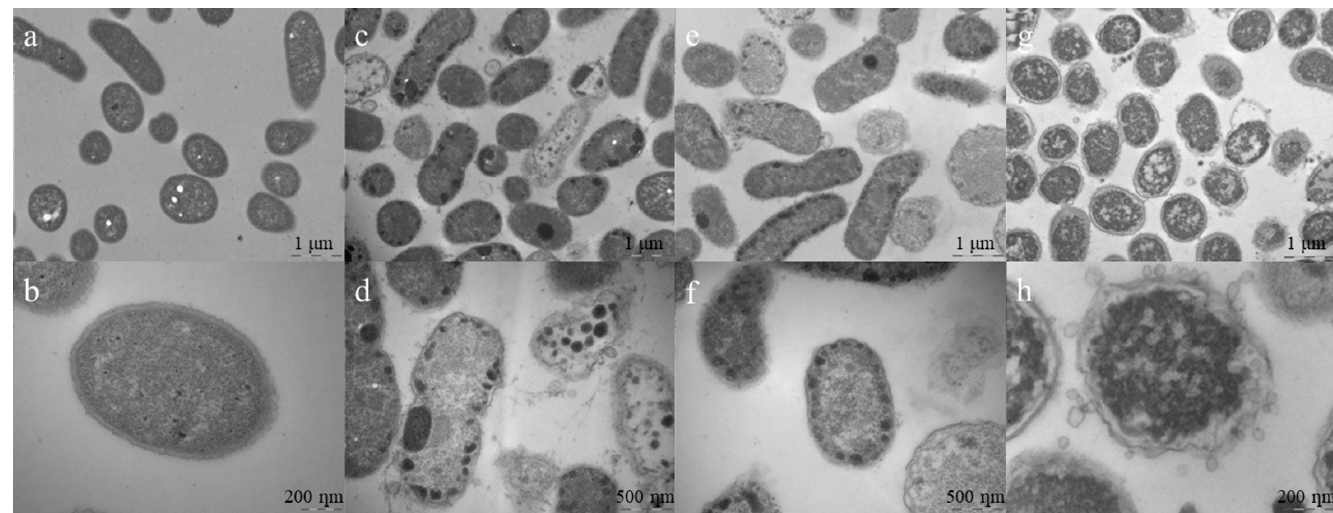
Figure 7 . TEM for A. baumannii ATCC 19606 treated with Pln149-PEP20 (MIC = 32 mg/L). ( a ) non-treated cells. Scale bar = 1 µm ( b ) non-treated cell in detail, with homogeneous intracellular content. Scale bar = 200 nm ( c ) 0.5 × MIC treated cells, showing some cell debris and condensation of cytoplasmic content. Scale bar = 1 µm ( d ) 0.5 × MIC treated cells, showing breakage of cell wall and membrane, besides condensation of cytoplasmic content in the peripheral area of cells. Scale bar = 500 nm ( e ) 1 × MIC treated cells, showing peripheral cytoplasmic condensation. Scale bar = 1 µm ( f ) 1 × MIC treated cells, showing peripheral cytoplasmic condensation and diffuse membranes. Scale bar = 500 nm ( g ) 4 × MIC treated cells, showing a heterogenous intracellular content distribution and bleb formation, typical of membrane disturbing treatments. Scale bar = 1 µm ( h ) 4 × MIC treated cell, with completely disturbed cell wall and membranes, surrounded by blebs. Scale bar = 200 nm .